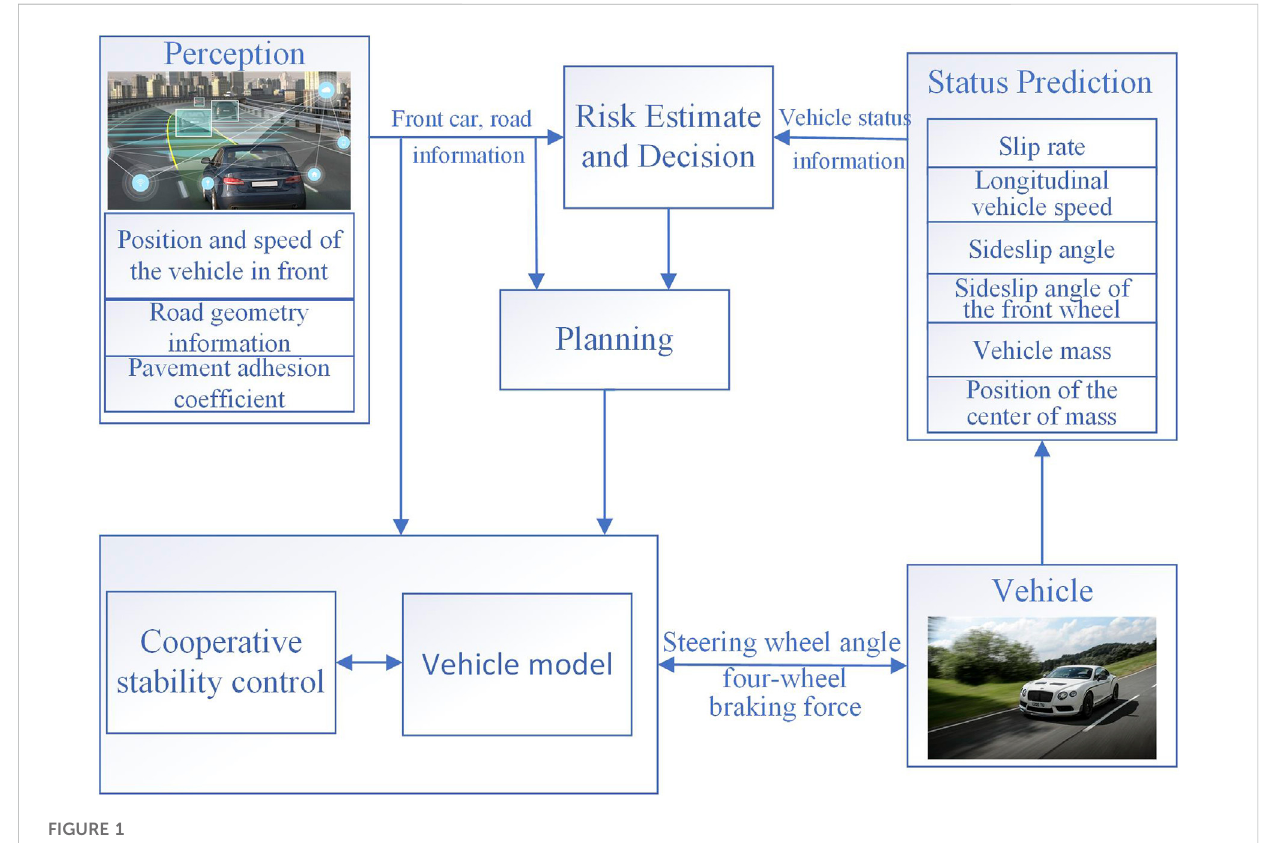
FIGURE 1 Coordinated control for vehicle driving stability and collision avoidance